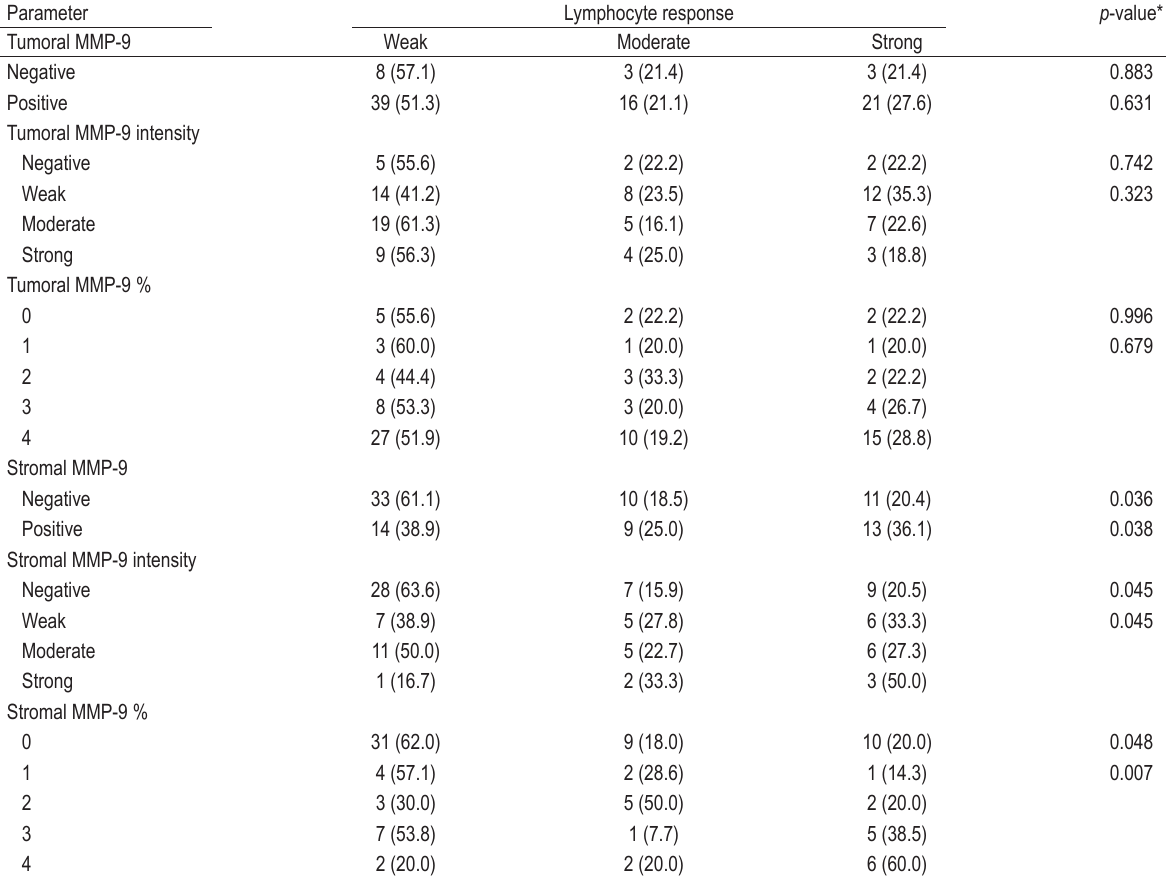
TABLE 5. MMP-9 expression and lymphocyte